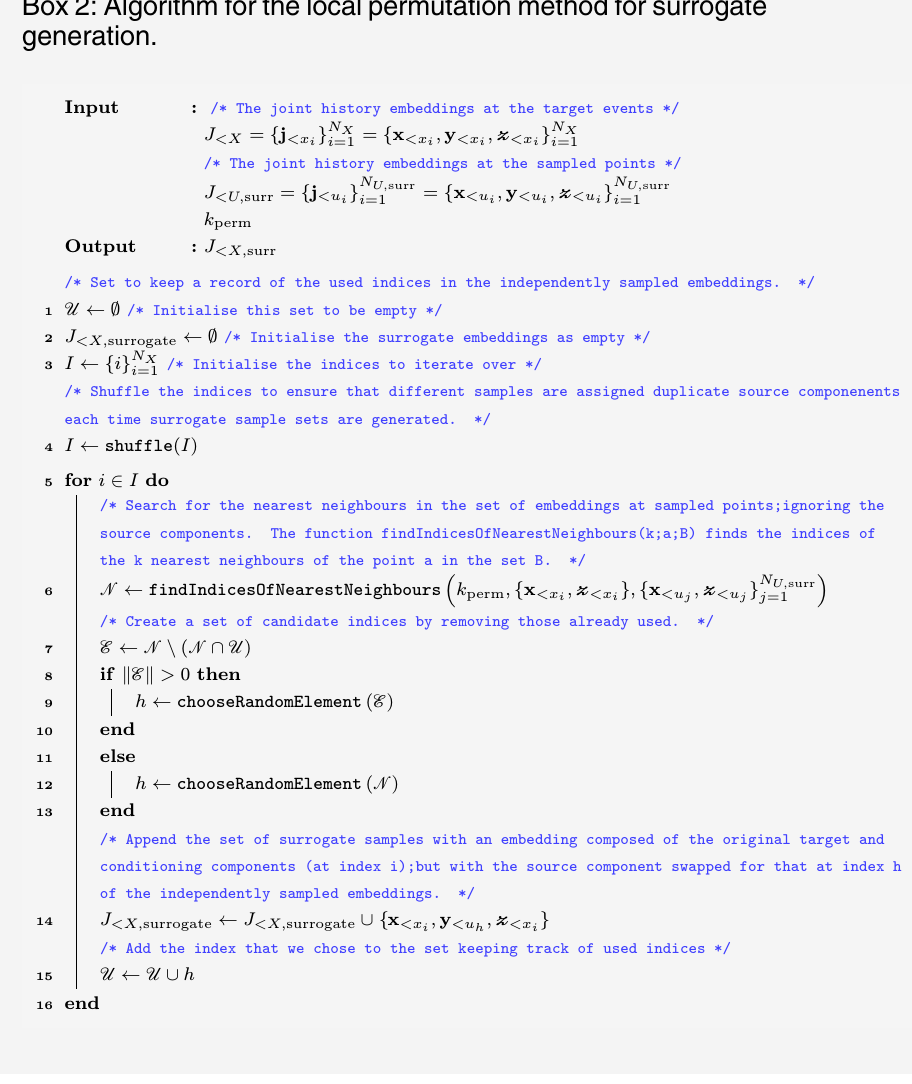
Box 2: Algorithm for the local permutation method for surrogate